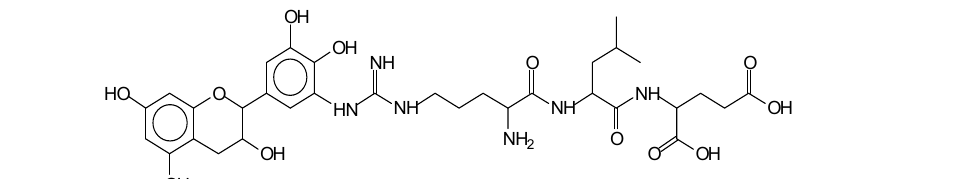
688.8 Da = no Na + , calculated 688.7 Da., robinetinidin-arginin-leucin-aspartic acid. Thus, the flavonoid attached to a peptide chain fragment.